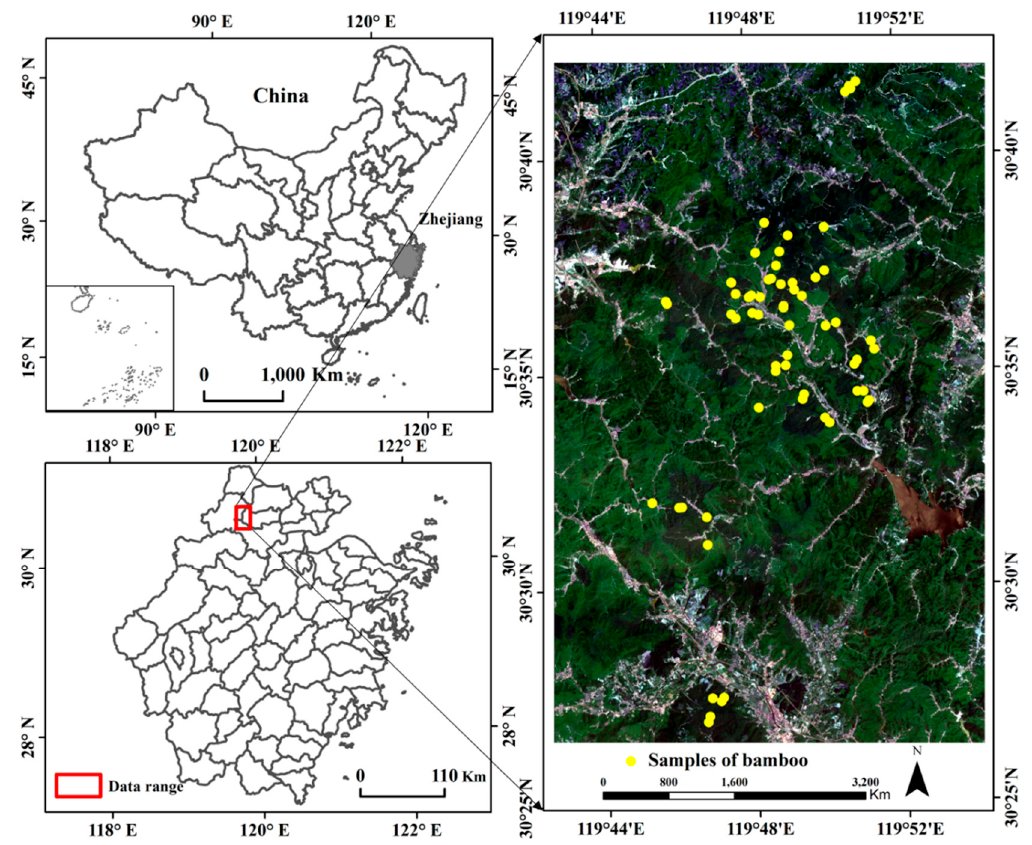
Figure 3. Study area in northwest Zhejiang Province, China.